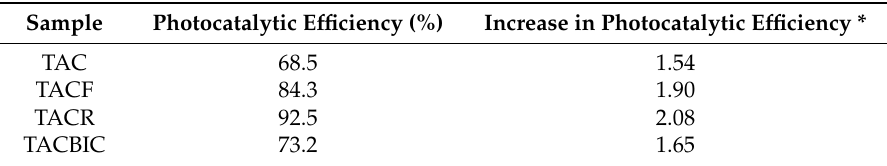
Table 2. Photocatalytic results obtained on TiO 2 -coated fabric samples.